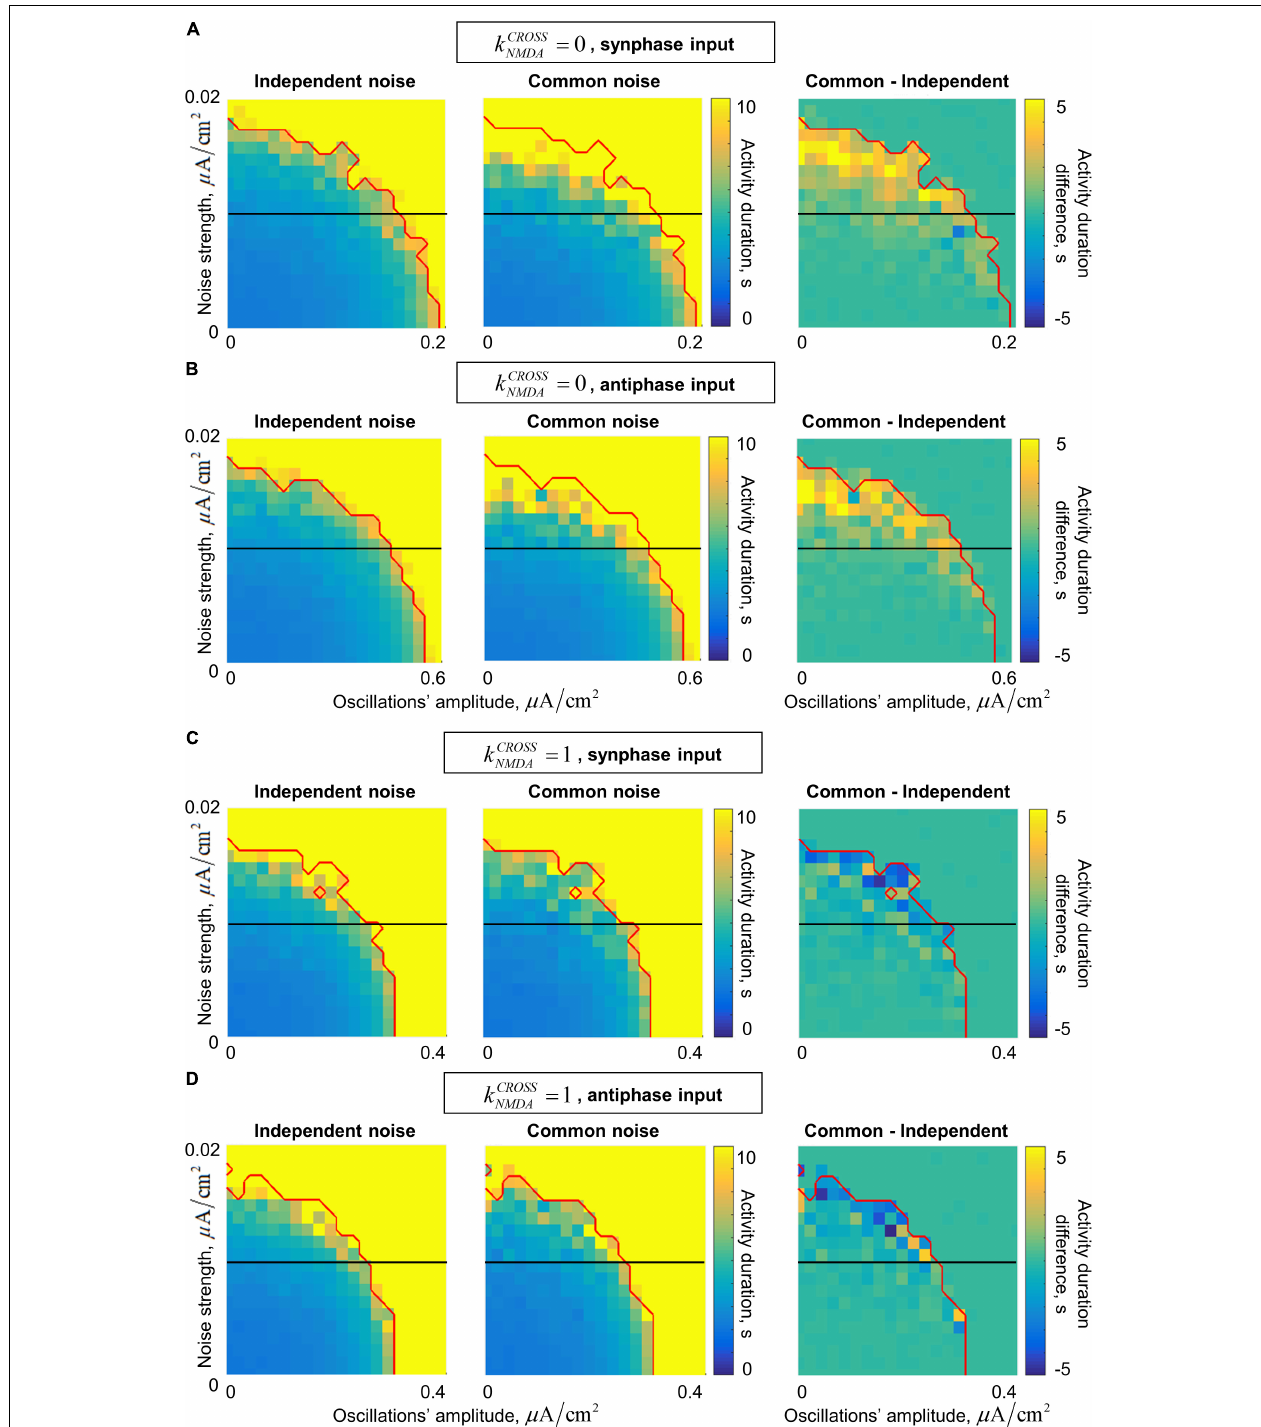
FIGURE 6 | Dependence of the post-stimulus activity duration in the two-circuit system on the amplitude of the input oscillations and the strength of the input noise for the in/anti-phase oscillations and two values of the NMDA connections strength. (A,B) Fast inter-circuit connection, (C,D) slow inter-circuit connections. (A,C) The circuits receive oscillatory signals in the same phase, (B,D) the circuits receive oscillatory signals in the opposite phases. Left column – each circuit receives an independent noise input; middle column – the circuits receive a common noise input; right column – the difference between these two cases. Red curve denotes the border of the saturation region: above this curve, the activity duration either for the common or for the independent noise case equals to the simulation time (i.e., above this curve comparison between the noise types does not make sense). Horizontal black lines denote the noise level of 0.01 (used further in the text). When the inter-circuit connections are fast, the activity is more robust (its duration is longer) in the case of common noise (yellow regions in the right panels of (A,B) ). When the connections are slow, the activity is slightly more robust in the case of independent noise (blue regions in the right panels of (C,D) ).